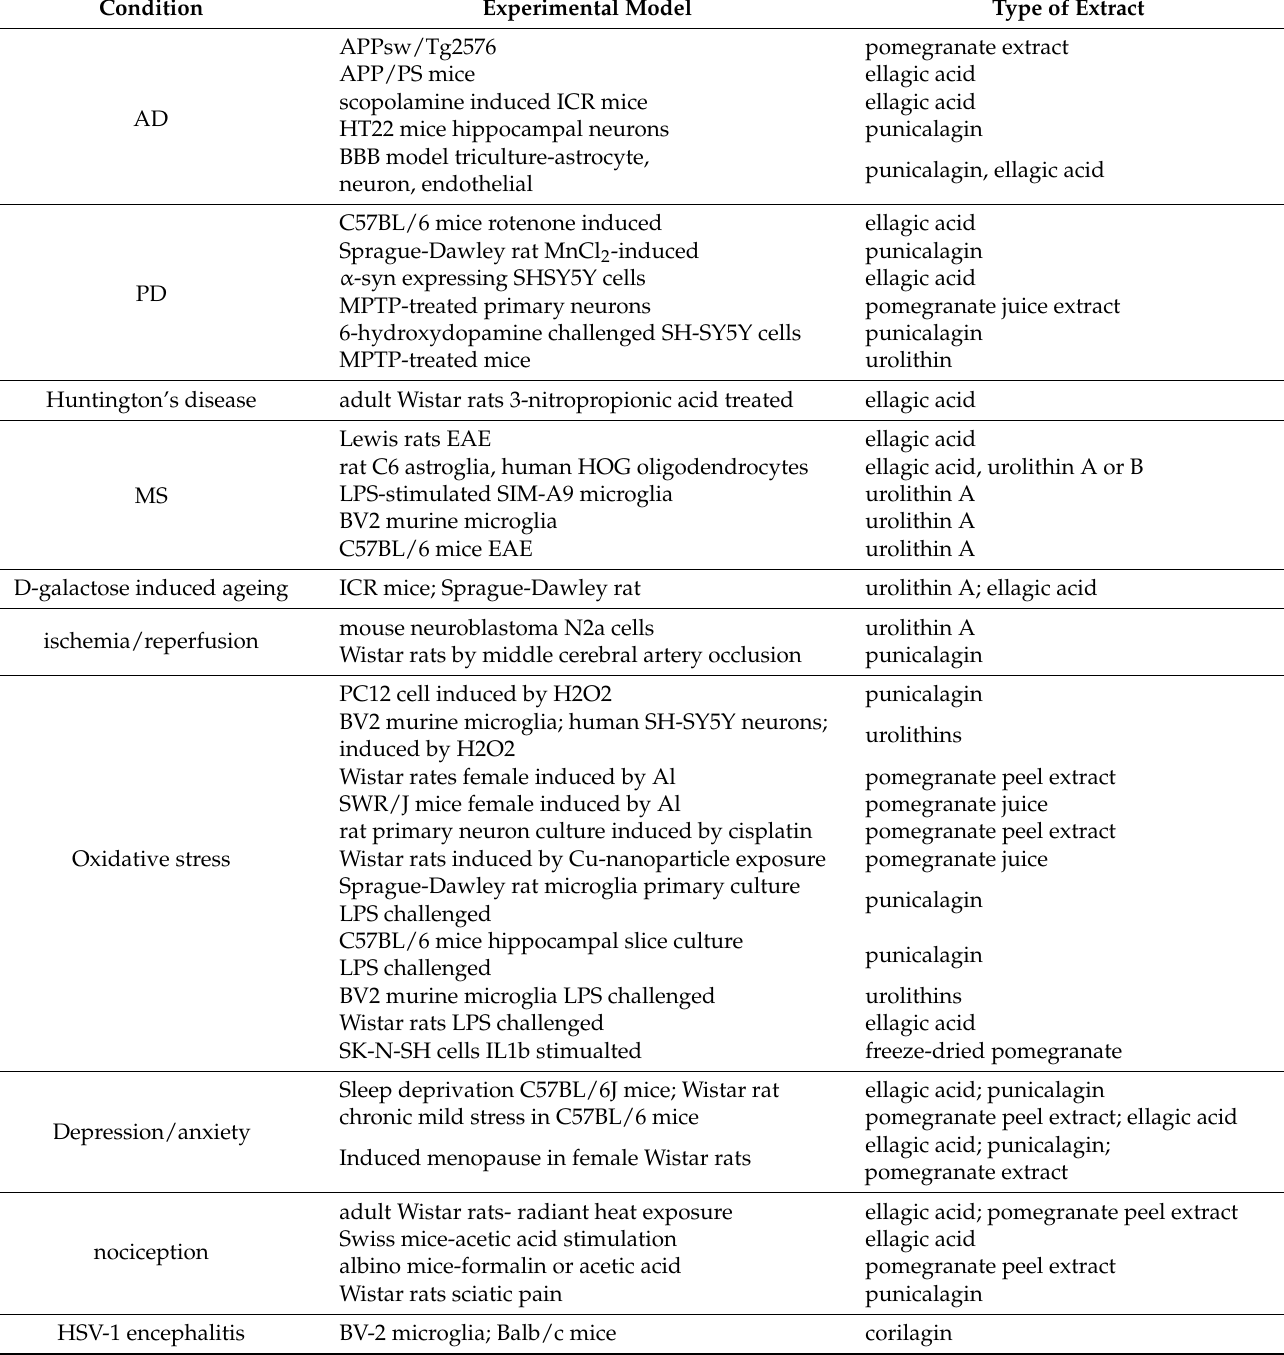
Table 1. Pomegranate products commonly used in research